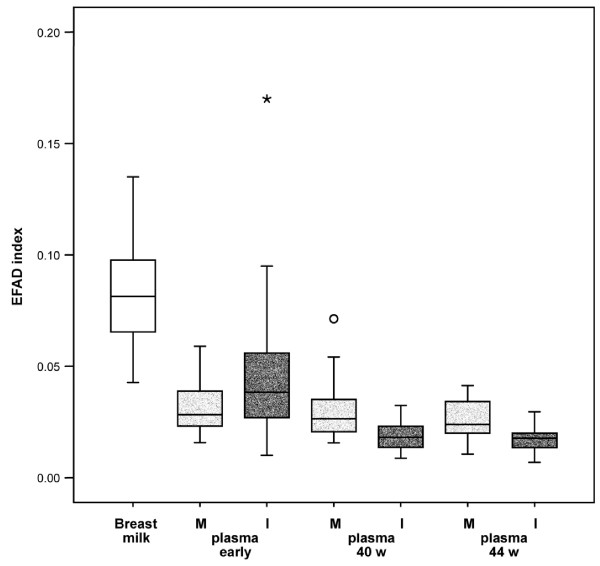
Box plot of the essential fatty acid (EFA) deficiency index (the mead acid 20:3w9/arachidonic acid 20:4w6 ratio) in breast milk (unfilled) and in mothers' (M, grey) and infants' (I, dotted) plasma phospholipids from 1 week of age (early) to 44 weeks of gestational age. The boxes indicate medians and 25th–75th percentiles. Whiskers indicate 5th to 95th percentiles and outliers are indicated by separate symbols.